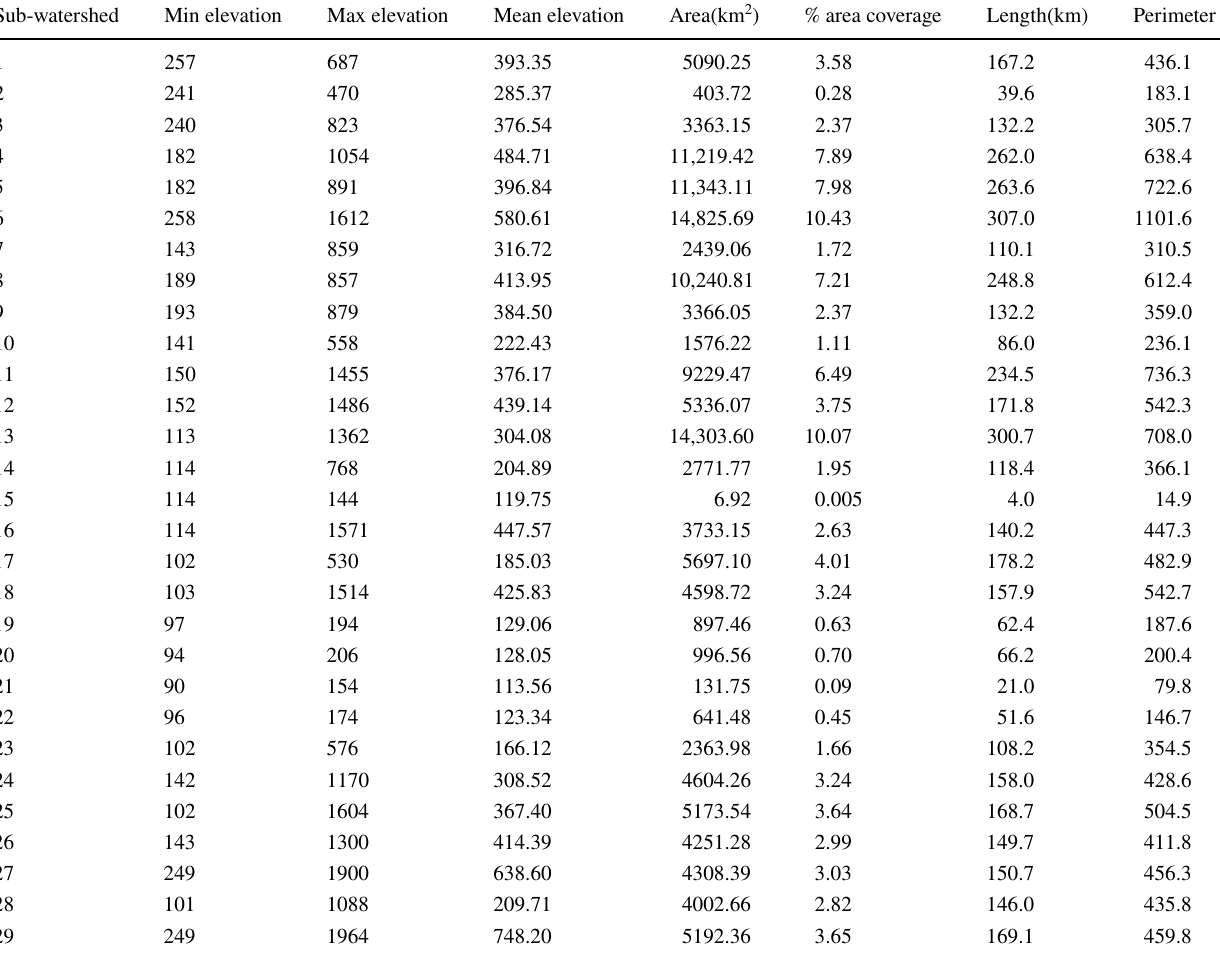
Table 3 Characteristics of sub-watershed